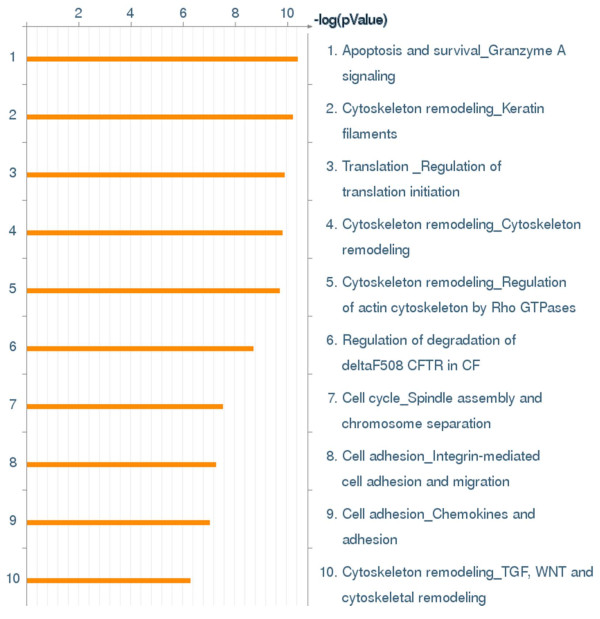
First 10 most differentially represented biological pathways identified in the set of proteins across all experimental conditions. The complete list of top 50 statistically significant pathways is given in Additional file 2, Figure S2.